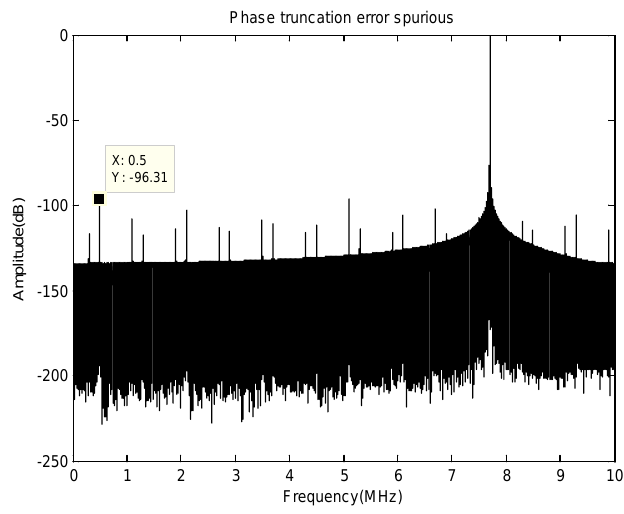
Figure 7. Phase truncation error spurious.